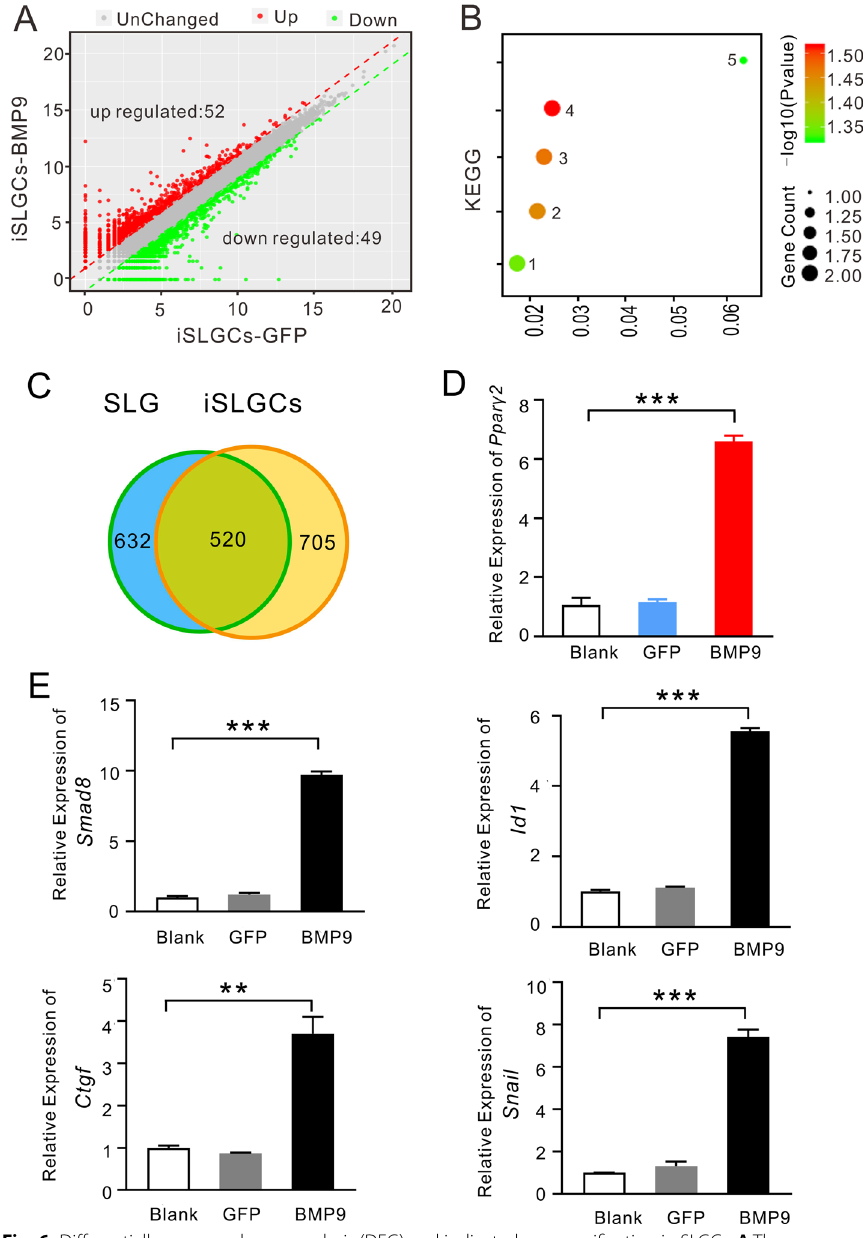
Fig. 6 Differentially expressed gene analysis (DEG) and indicated gene verification in SLGCs. A The significantly upregulated (52) and downregulated (49) DEGs induced by Ad-BMP9 in iSLGCs. B KEGG enrichment signaling pathways included: amoebiasis (1), small-cell lung cancer (2), protein digestion and absorption (3), PPAR signaling pathway (4), and thiamine metabolism (5). C Overlap of metabolic gene expression between the cell line and tissues. There were 520 metabolism-related genes coexpressed between SLG and iSLGCs. D The expression of Pparγ-2 was increased upon the induction of Ad-BMP9. E The upregulated expression levels of Id1 and Smad8 were confirmed using RT-qPCR demonstrating the activity of BMP9. BMP9 stimulated Ctgf and Snai1 expression in iSLGCs. All experiments were repeated at least three times. ** P < 0.01, *** P <